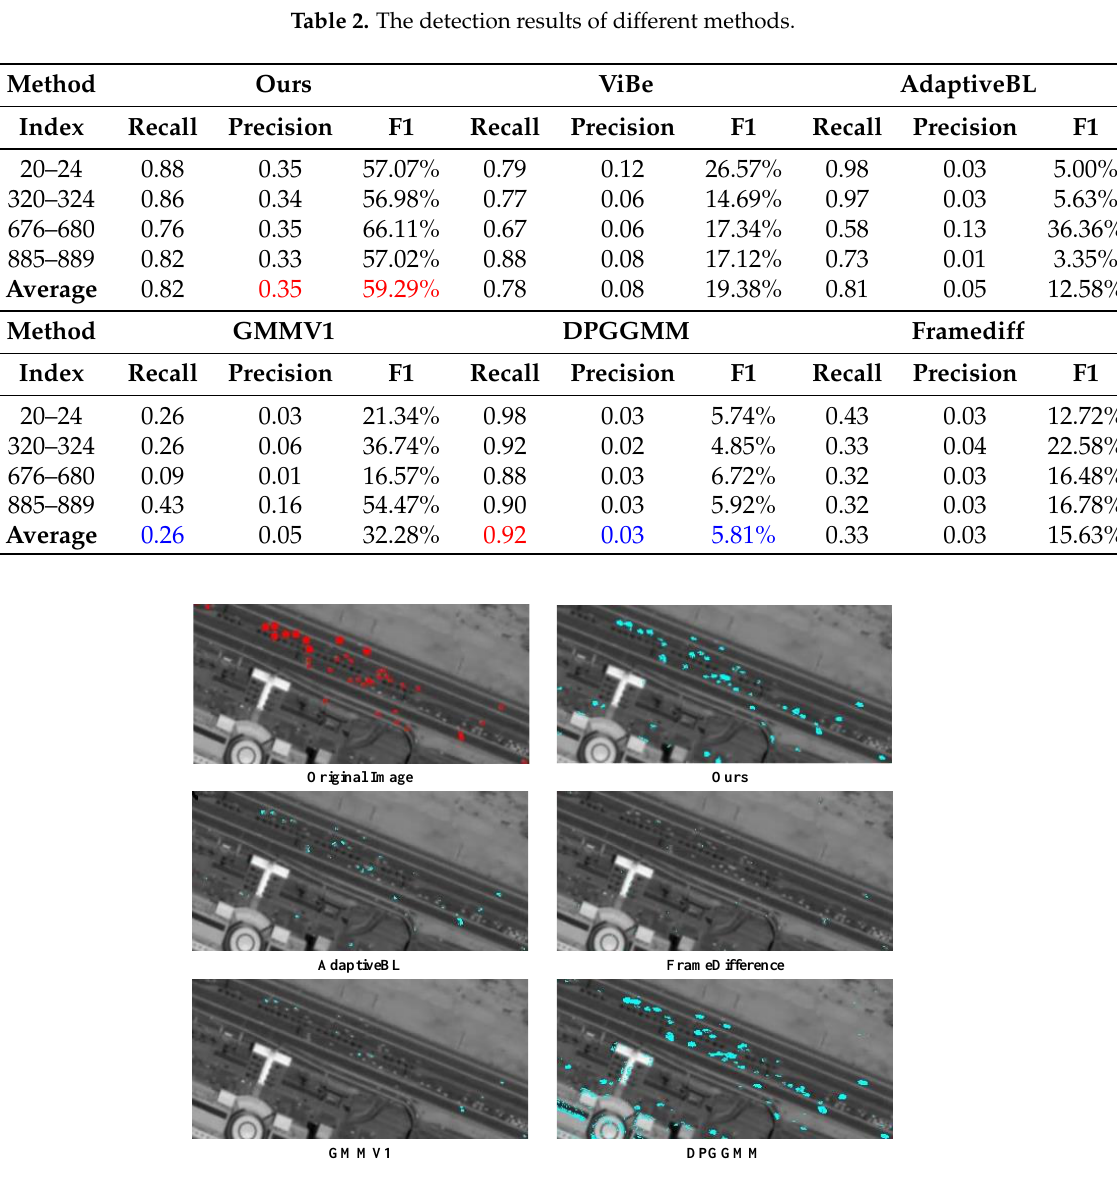
Figure 11. Partially enlarged details of detection results using different